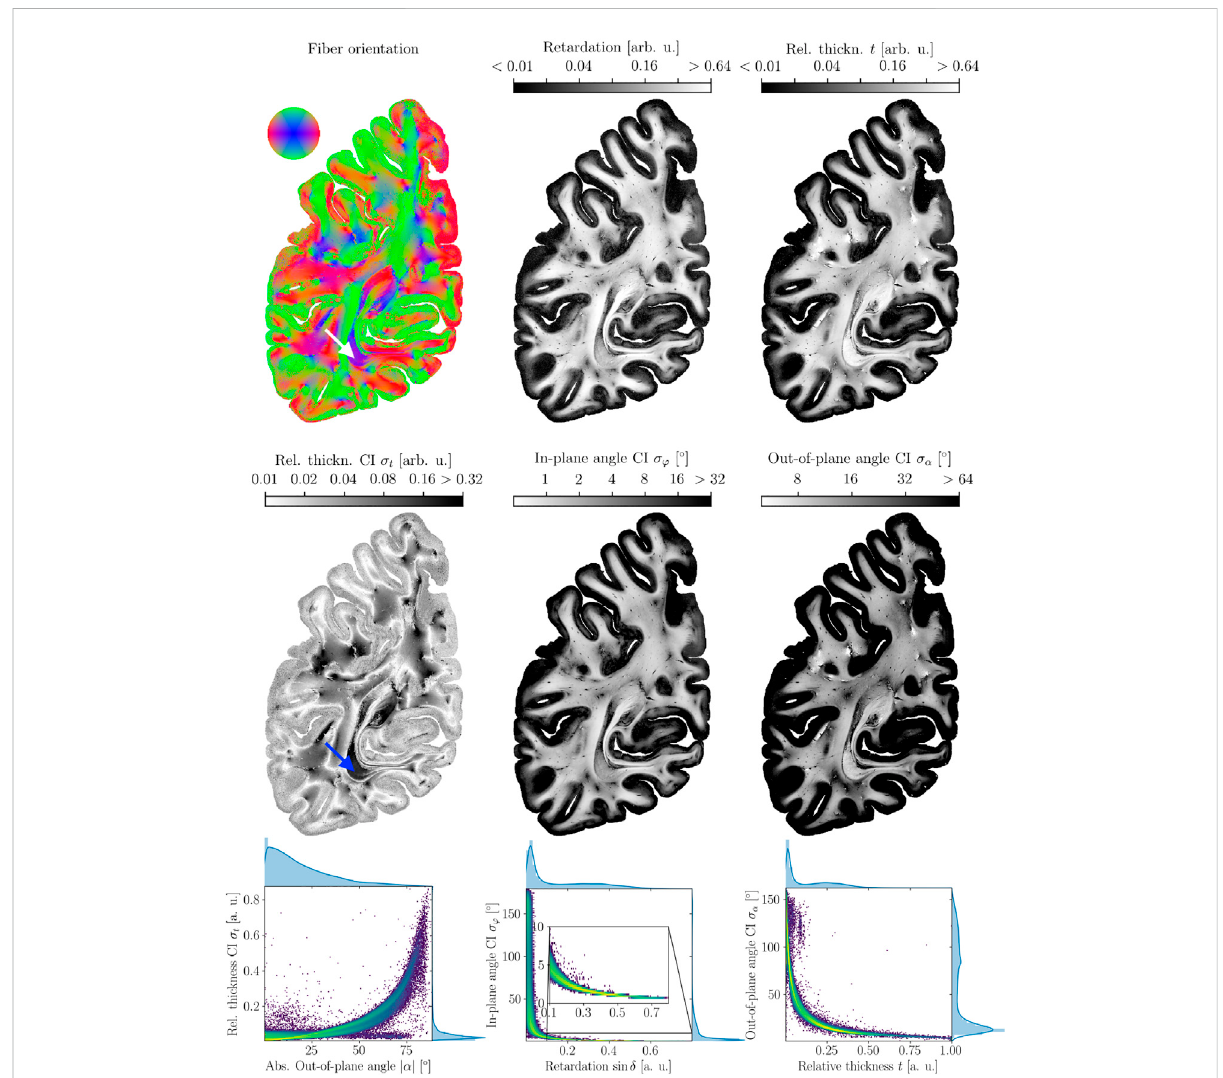
FIGURE 2 3D-PLI modalities and their credible intervals. Top row: maps of best- fi t parameters. From left to right: Fiber Orientation map, retardation map, relative thickness map. Contrary to typical visualizations in dMRI, the brightness of the FOM was not scaled to emphasize the arbitrary orientations inferred for vanishing signals in the cortex. Middle row: credible interval maps. From left to right: relative thickness credible interval, direction angle credibleinterval,inclinationanglecredibleinterval.Notetheinvertedgrayscalecolorbar:areaswithhighcon fi denceandlowcredibleintervals, respectively, are brighter than areas of low con fi dence. All scalar maps are log scaled. The arrows (white and blue, upper and middle row left) point out the stratum sagittal, which contains dominantly strongly inclined nerve fi bers concerning the coronal sectioning plane. Overall, a correlation between thez-component whichmanifests inbluecoloring in theFOM, and σ t can beobserved. For the angular credible intervals, correlations exist between the retardation and the in-plane orientation con fi dence σ φ (middle column) and relative thickness t and out-of-plane orientation con fi dence σ α (right column). Bottom row: correlations between the parameters visualized as log scaled two-dimensional